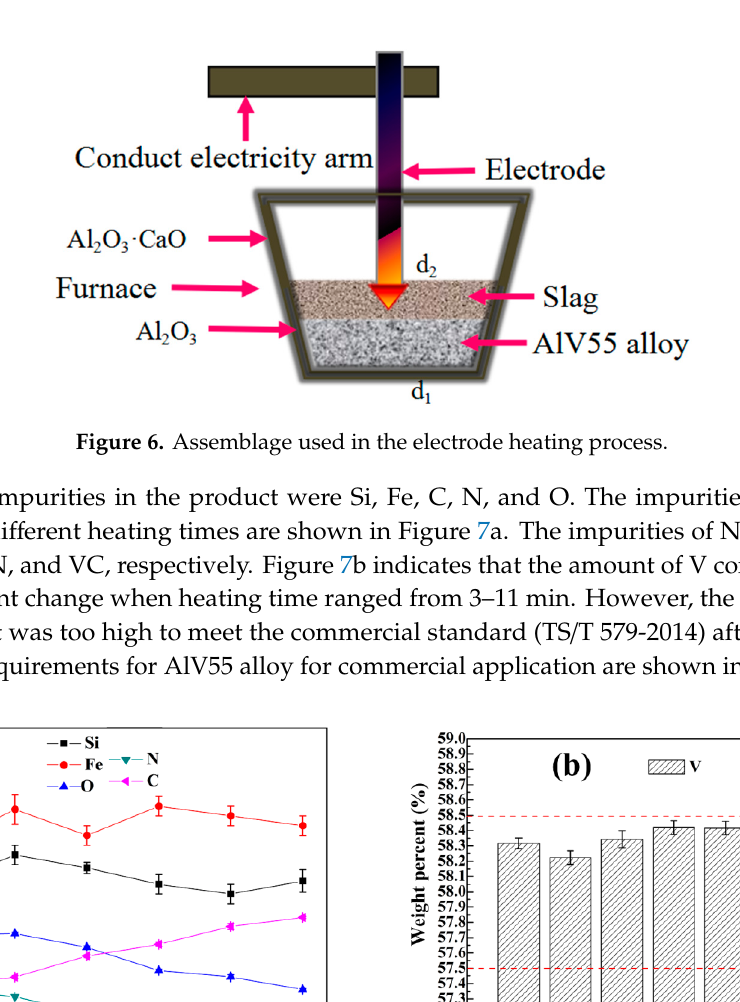
Table 3. The composition of the AlV55 alloy for commercial application (TS/T 579 ‐ 2014).